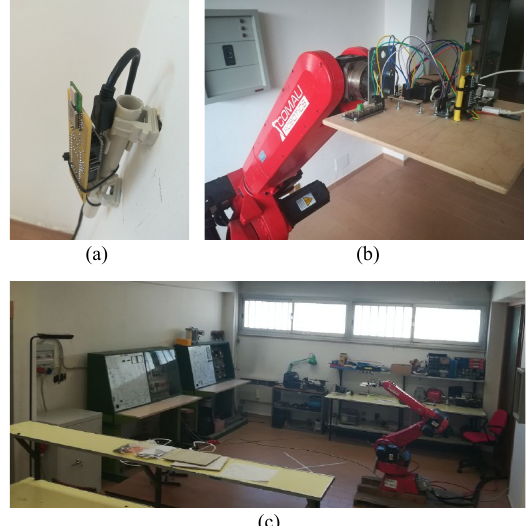
Figure A1. Photo of the experimental setup: ( a ) fixed beacon, ( b ) mobile plate to be tracked, ( c ) in- door